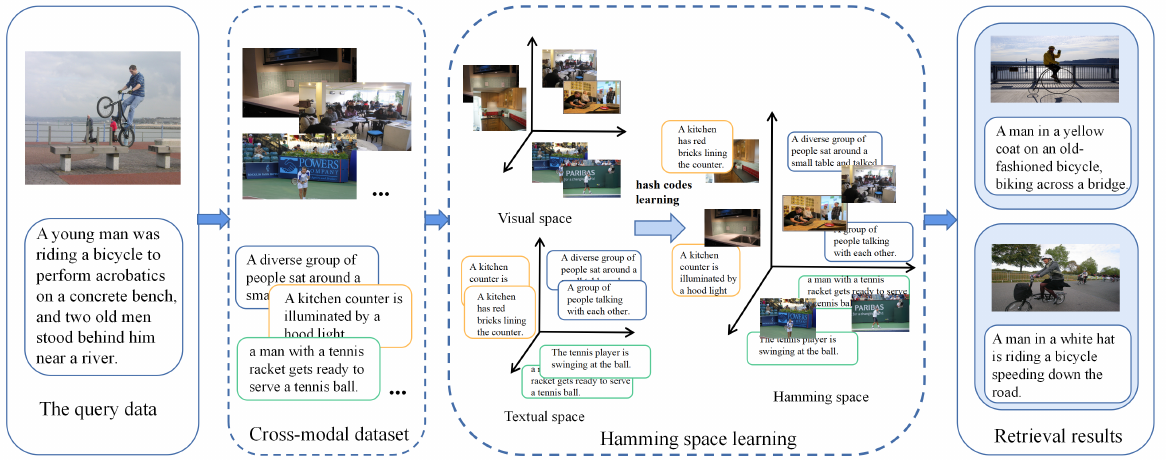
Figure 1. A brief illustration of multi-modal hashing retrieval. The cross-modal hashing method maps the original data into a unified Hamming (binary code) space. Meanwhile, the semantic similarity of the data is preserved during the mapping process. (The more semantically similar the original multimedia data is mapped to a common Hamming space, the closer the distance between their hash codes and vice